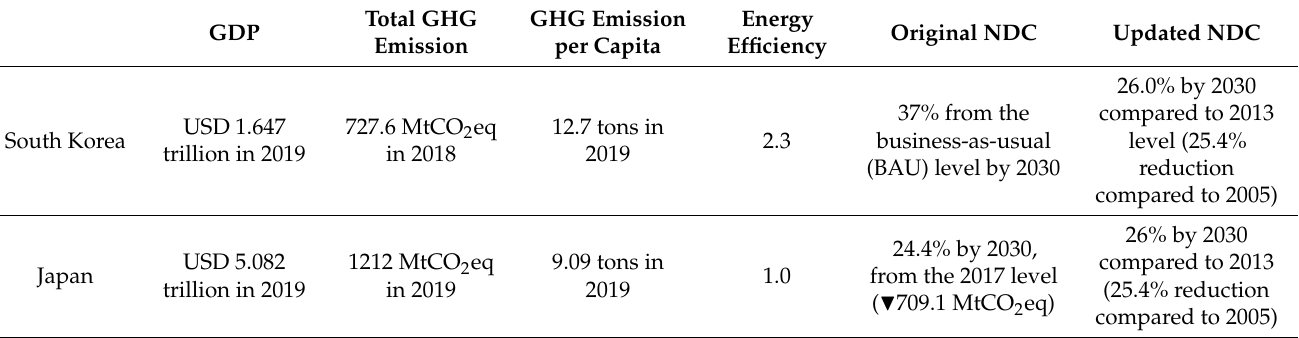
Table 1. Comparison between South Korea and